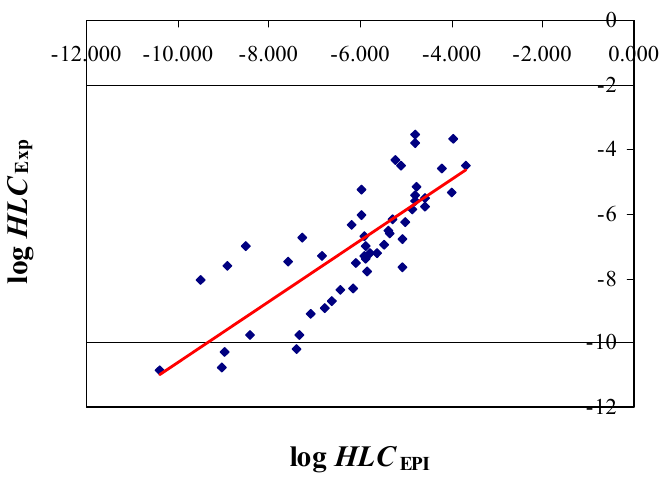
Figure 2. Visualization of the EPI-based modified QSAR modeling of log HLC based on 49 OP